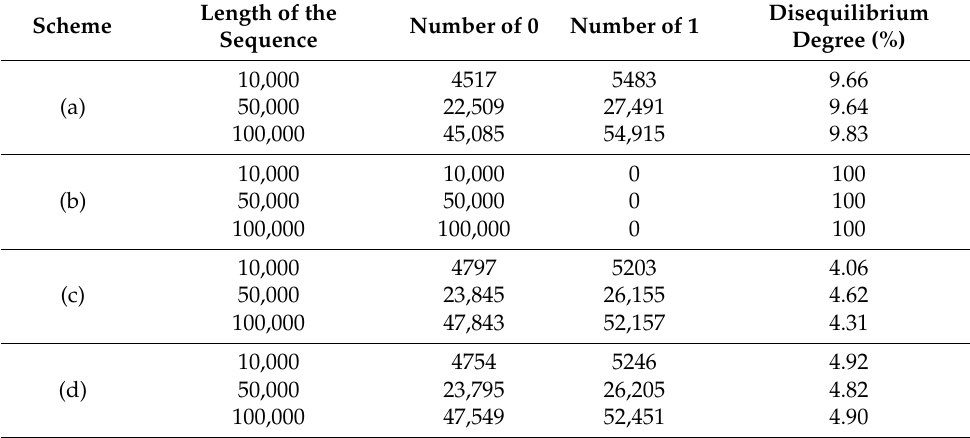
Table 1. The disequilibrium degree of proposed improved CMLs. (a) The original CML based on logistic map; (b) The original CML based on tent map; (c) The improved CML based on logistic map; (d) The improved CML based on tent map; (e) The improved four stage compound CML, combining both logistic map and tent map in a single stage; (f) The improved four stage compound CML, combining logistic map and tent map in an alternate